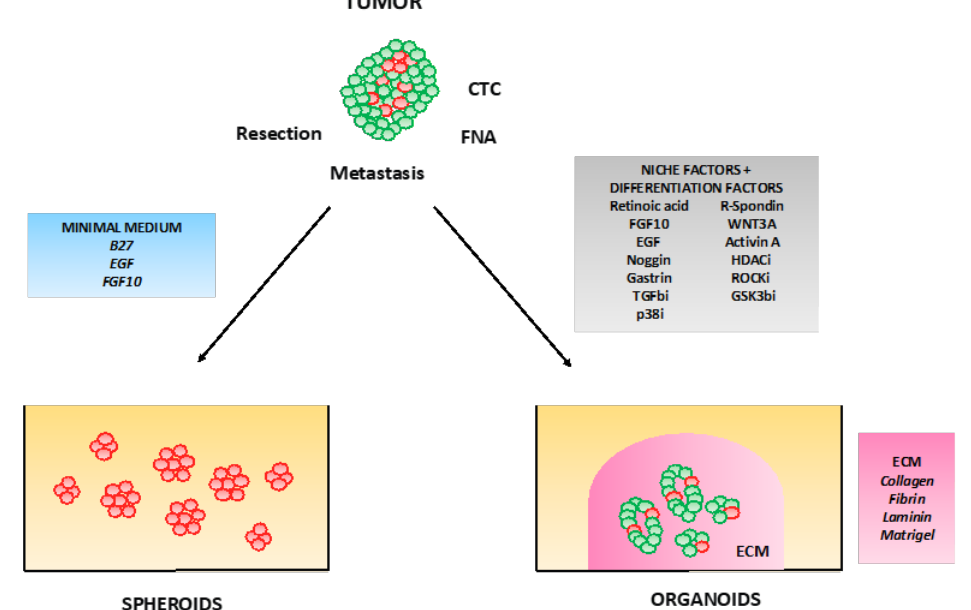
Figure 1. Spheroids vs. organoids. Spheroids or spheres are obtained by tissue or cancer stem cells growth in a minimum serum-free medium. Their spherical morphology triggers an oxygen and nutrient gradient towards the center, leading often to massive cell death in the center of the structure. Spheroids are lacking the capacity to form tissue-like structure. Organoids in contrast to spheroids require stem cell niche factors and extra-cellular matrix (ECM), which allow stem cells to express their differentiation and self-organization capacity. In addition, this structure due to the presence of a lumen does not exhibit a hypoxic or nutrient gradient. CTC: Circulating tumor cells, FNA: Fine needle aspiration. Red cells: Stem cells, green cells: differentiated cells.